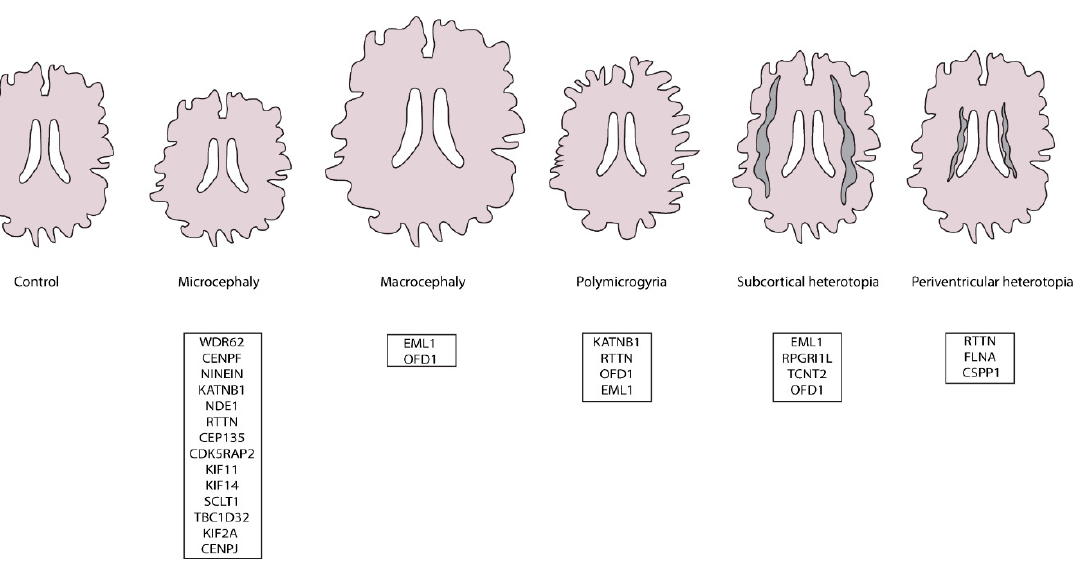
Figure 2. Schematic representation of human cortical malformations mentioned in this review and related ciliary genes that are known to be mutated in human patients.